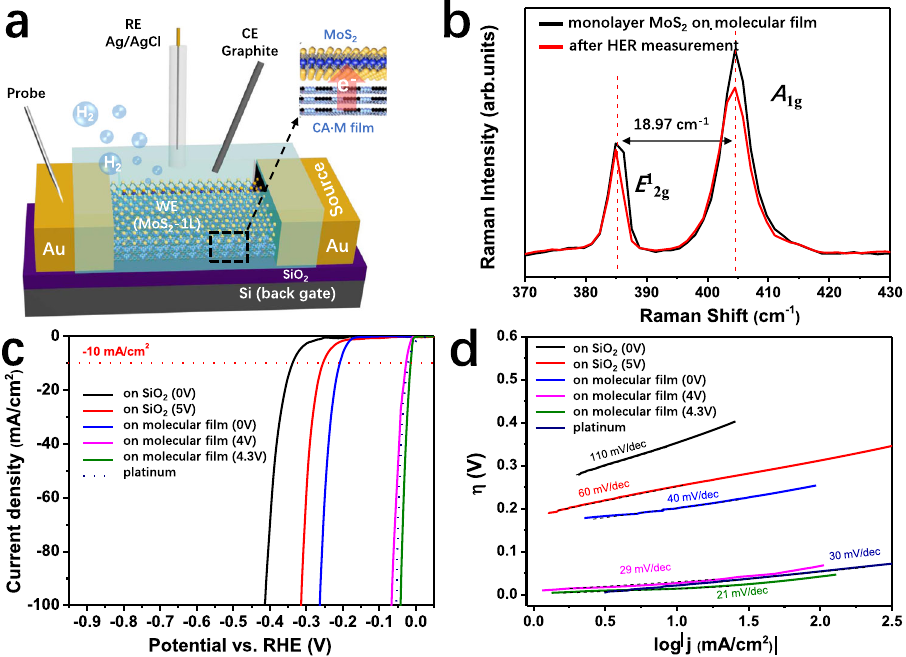
Fig. 5 Hydrogen evolution reaction (HER) in the co-assembled supermolecule network (CA·M)/MoS 2 heterostructure. a Monolayer MoS 2 on CA·M molecular fi lm device for HER measurements. The red arrow indicates the charge transfer direction in the heterostructure. b Raman spectra of the monolayer MoS 2 fl ake on CA·M before (black) and after (red) HER measurements, and Raman peak positions are marked by the dashed lines. c The polarization curves for HER on Platinum (dashed blue line) and monolayer MoS 2 fl akes under different conditions (SiO 2 substrate with/without 2D CA·M buffer layer, and the respective voltages applied gate). The − 10 mA cm − 2 current density position is marked by the dashed red line. d Corresponding Tafel